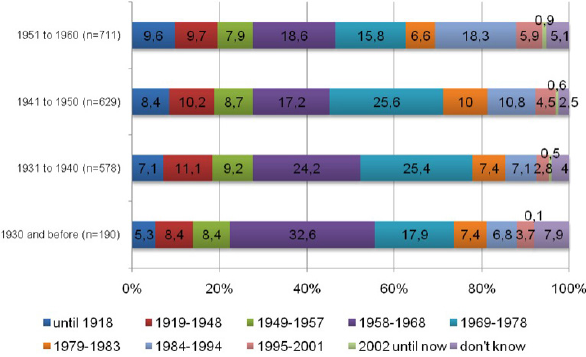
Figure 4. Year of construction of the residential buildings (coloured bars) the respondents live in, divided by age groups (y- axis representing age groups by ranges of year of birth); data from the survey on elderly people within the city of Aachen.